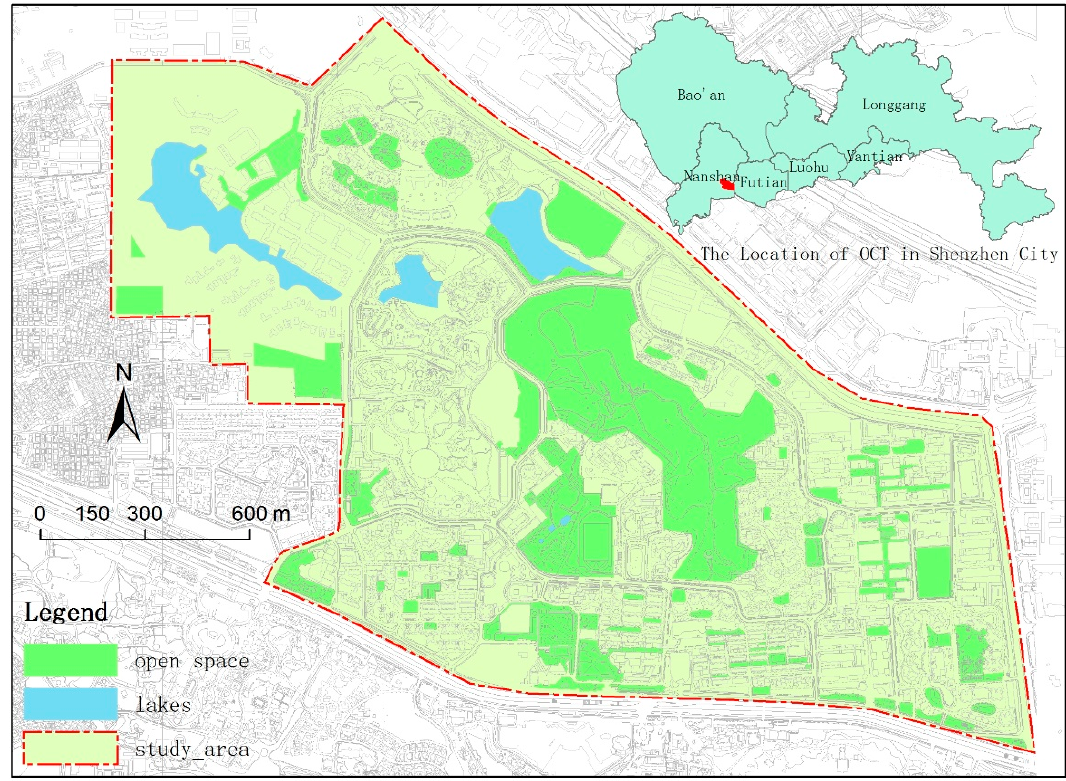
Figure 1. Study area and its location.